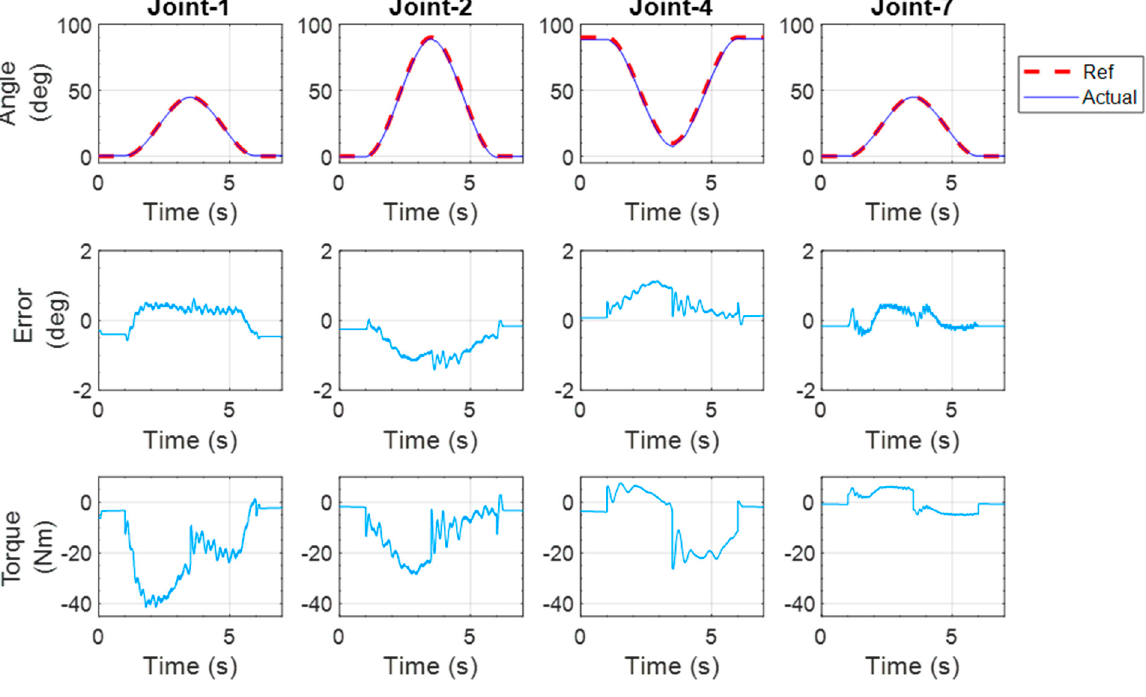
Figure 24. Experimental results of the diagonal reaching exercise.